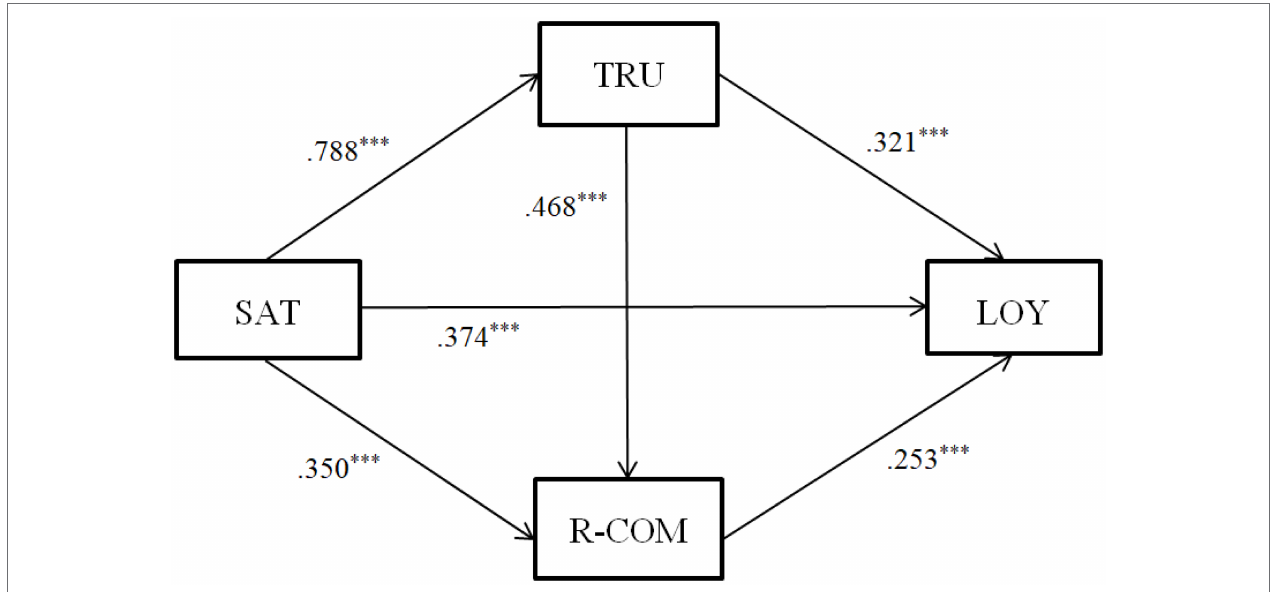
FIGURE 1 | The chain mediation model. SAT, parental satisfaction; TRU, parental trust; R-COM, parental relationship commitment; LOY, parental loyalty; and *** p <